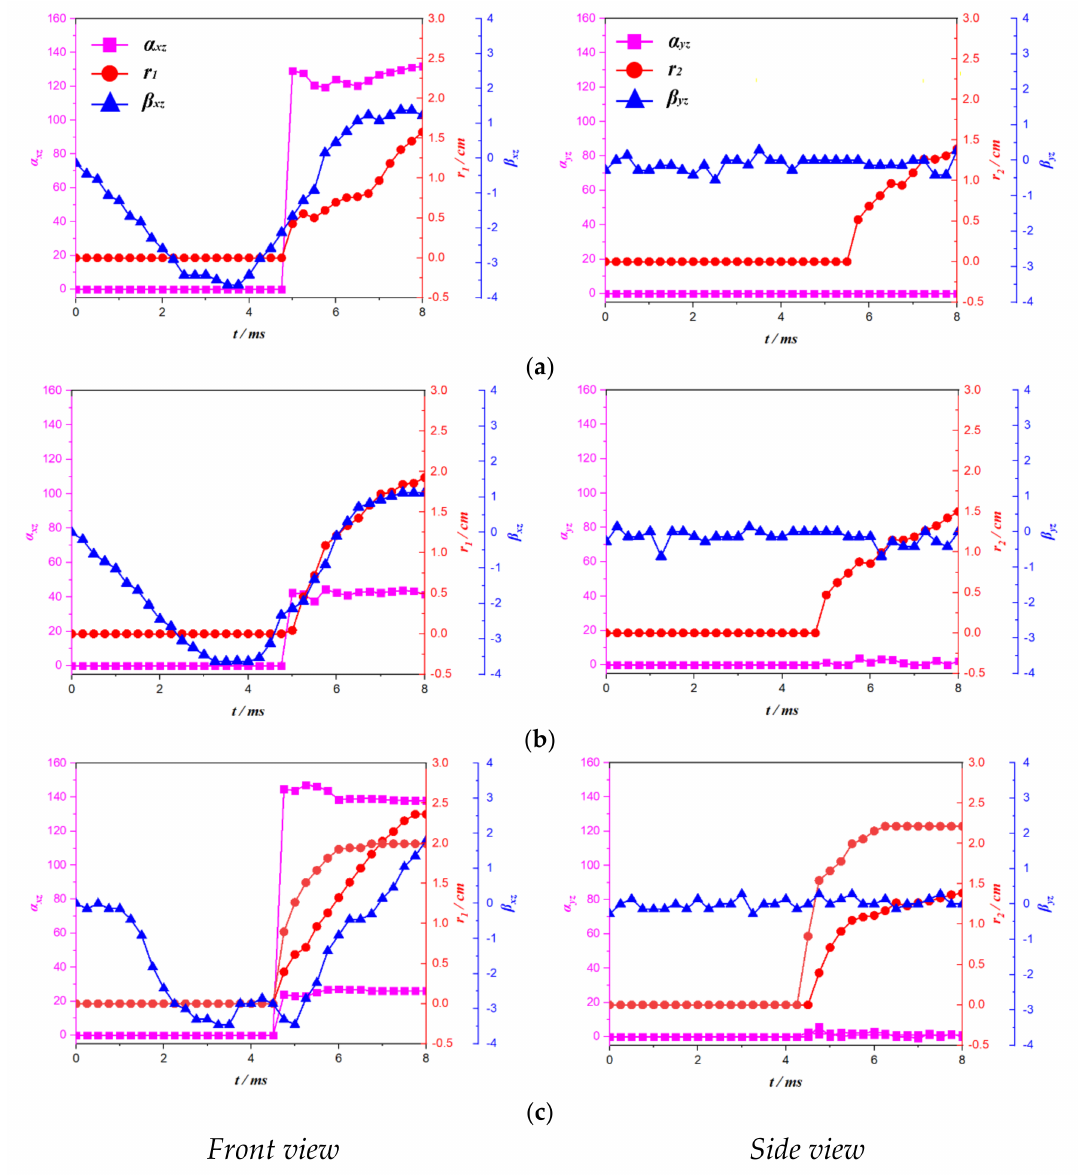
Figure 11. Effect of bending of C-1 plate at different initial positions on the direction of bubble migration. ( a ) γ = 1.65, ( b ) γ = 1.32, ( c ) γ =